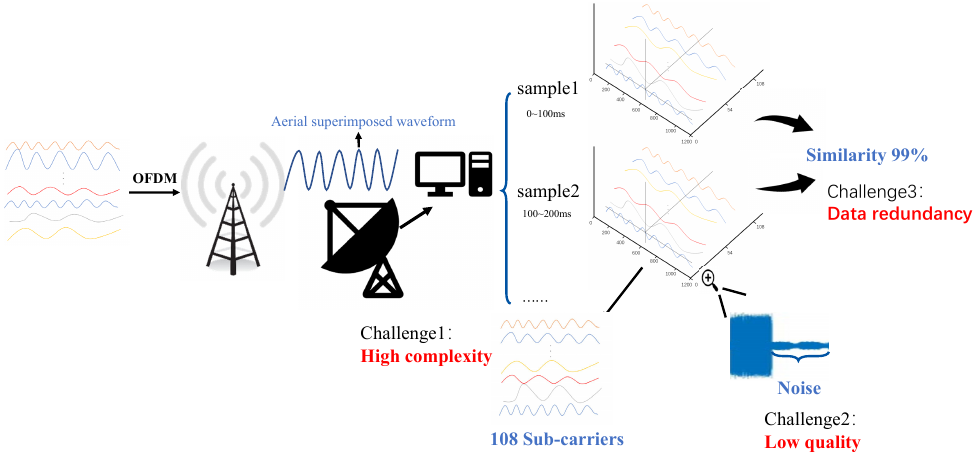
Figure 1. Challenges of OFDM signal identification. There are three challenges: high complexity, low quality and data redundancy. In particular, OFDM signals have 108 sub carriers, and the quality is likely to be poor, and our works are under the condition of